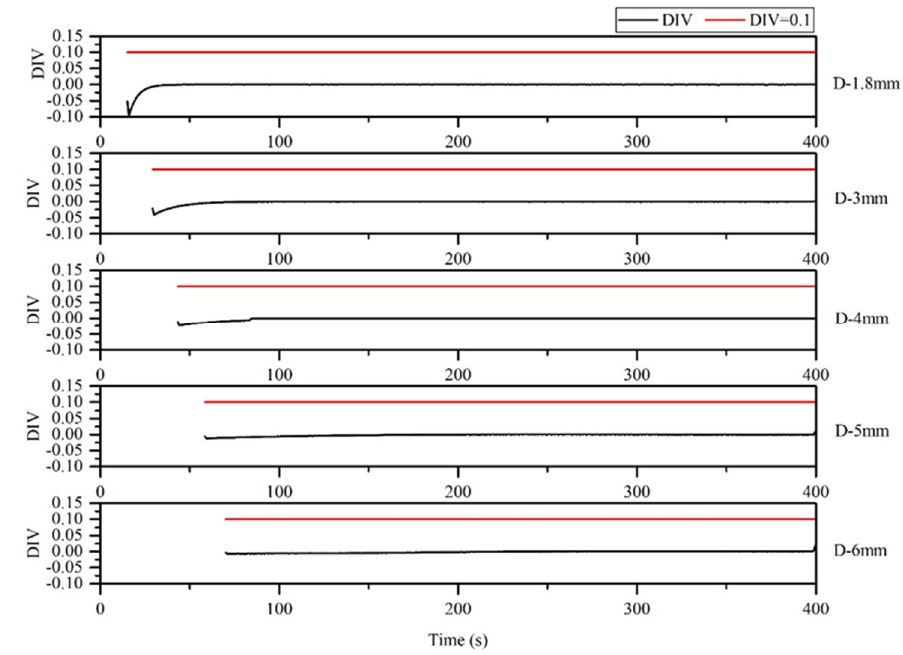
Figure 20. Viscosity curve in microreactor at different pipe diameters.